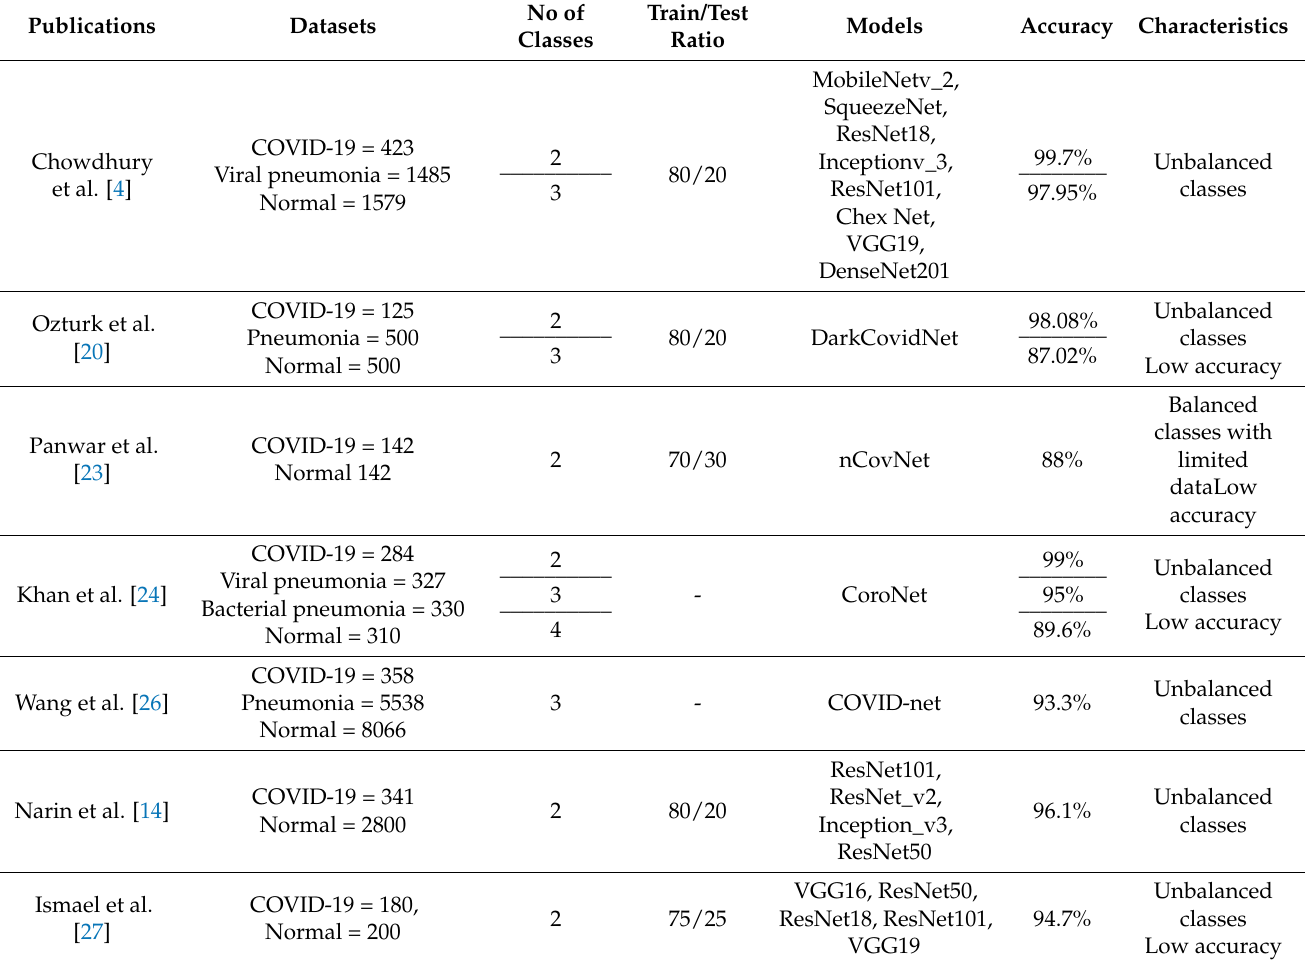
Table 1. Comparison and characteristics of related